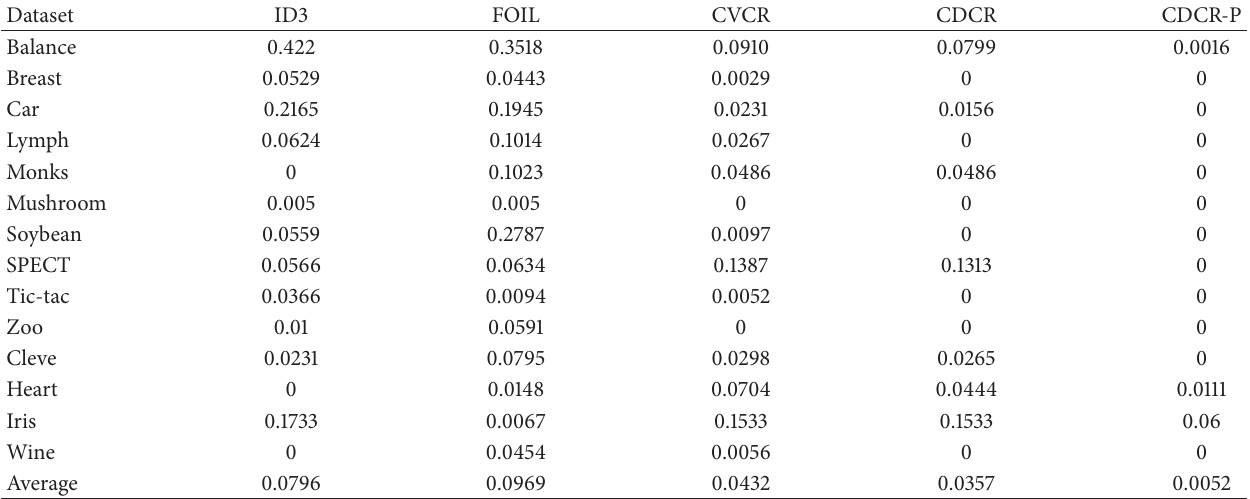
Table 3: The missing match rate of ID3, FOIL, CVCR, CDCR, and